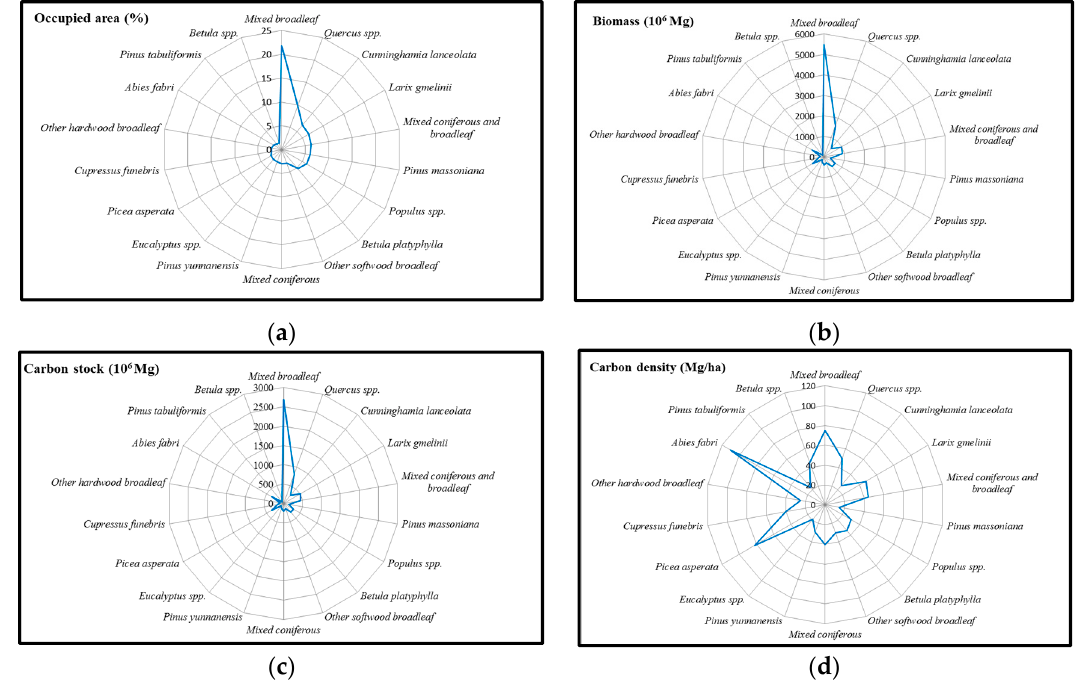
Figure 4. Species occupying more than 1% of China’s total arboreal forest area. Subfigures ( a ), ( b ), ( c ) and ( d ) are occupied area, biomass, carbon stock and carbon density of these species, respectively.